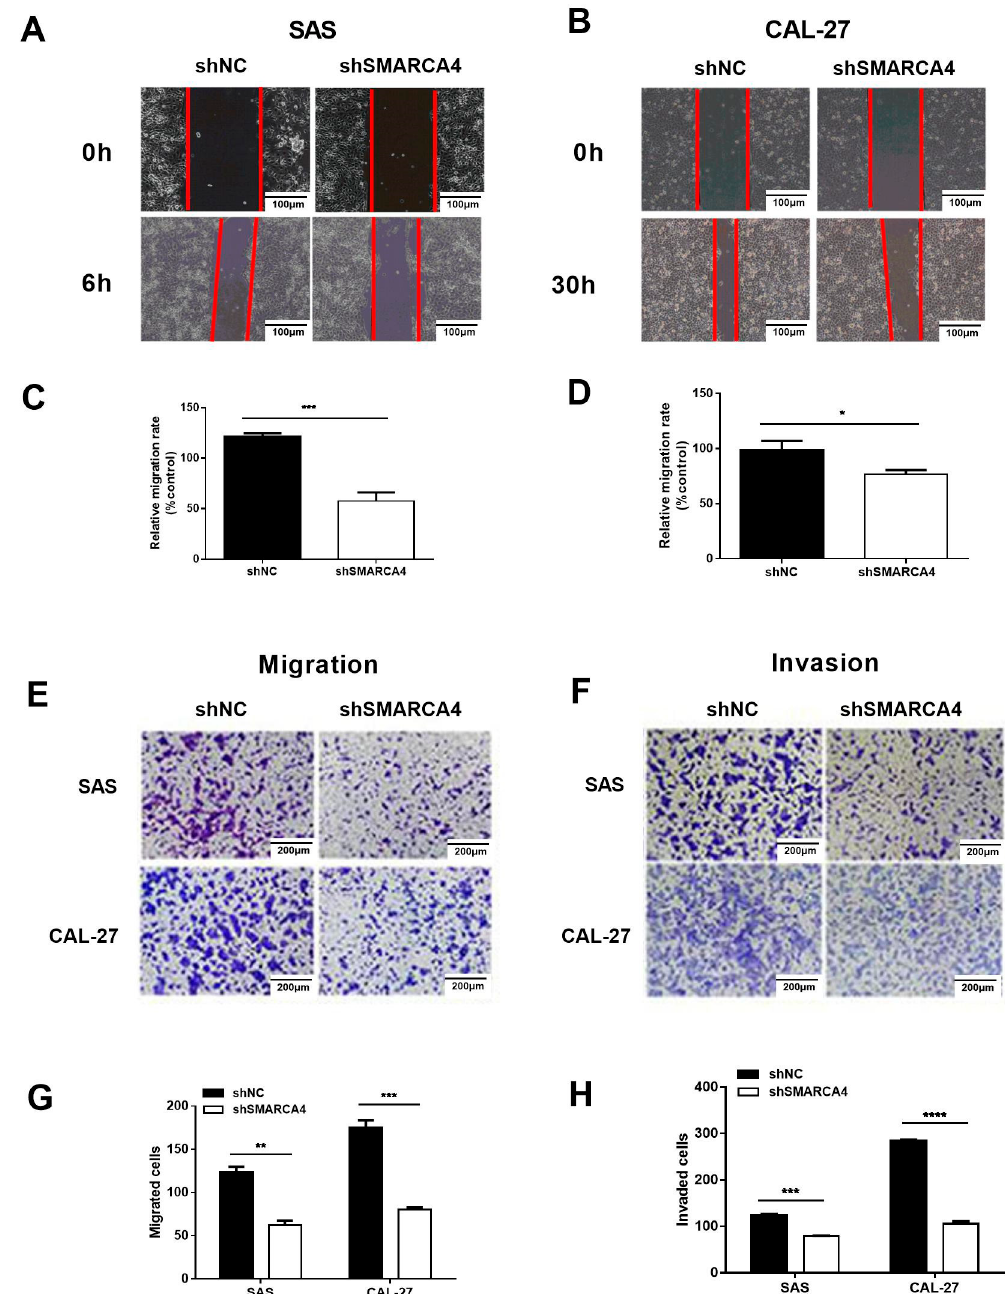
Figure 3. Knockdown of SMARCA4 inhibits OSCC cell migration and invasion. ( A – D ) The effect of SMARCA4 inhibition on OSCC cell migration. SAS or CAL-27 cells were transfected with sh- SMARCA4 or sh-NC for the indicated times (6 h for SAS, 30 h for CAL-27), and cell migration was assessed by the wound healing assay. Scale bar: 100 µ m ( A , B ). Quantitative analysis was performed using the Image J software ( C , D ). ( E – H ) The effect of SMARCA4 inhibition on OSCC cell migration and invasion. SAS or CAL-27 cells were transfected with sh-SMARCA4 or sh-NC for the indicated times (24 h for SAS, 48 h for CAL-27). Cell migration ( E ) and invasion ( F ) were assessed by Transwell migration and invasion assays. Scale bar: 200 µ m. Quantitative analysis was performed using the Image J software ( G , H ). Data are expressed as the mean ± SEM from triplicate experiments. * p < 0.05, ** p < 0.01, *** p < 0.001, **** p <0.0001 vs shNC